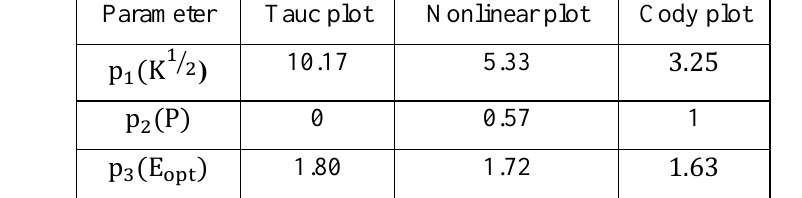
Table 2: Linear and nonlinear regression results and Cody plot of a-Si:H films.